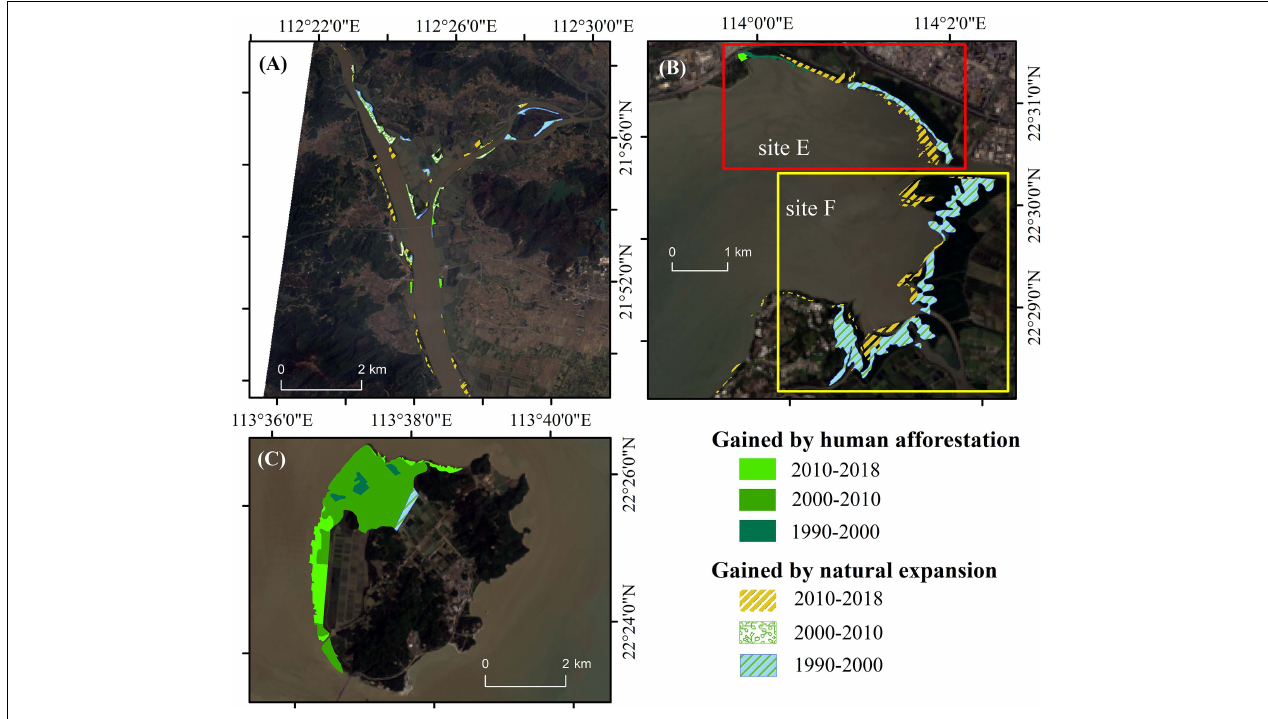
FIGURE 5 | Spatial-temporal distribution of restored estuarine mangrove area at estuarine mangrove sites. The gained mangrove area by human afforestation and natural establishment are marked with solid and variegated patches, respectively. (A) site A, (B) site E and F; (C) site D.